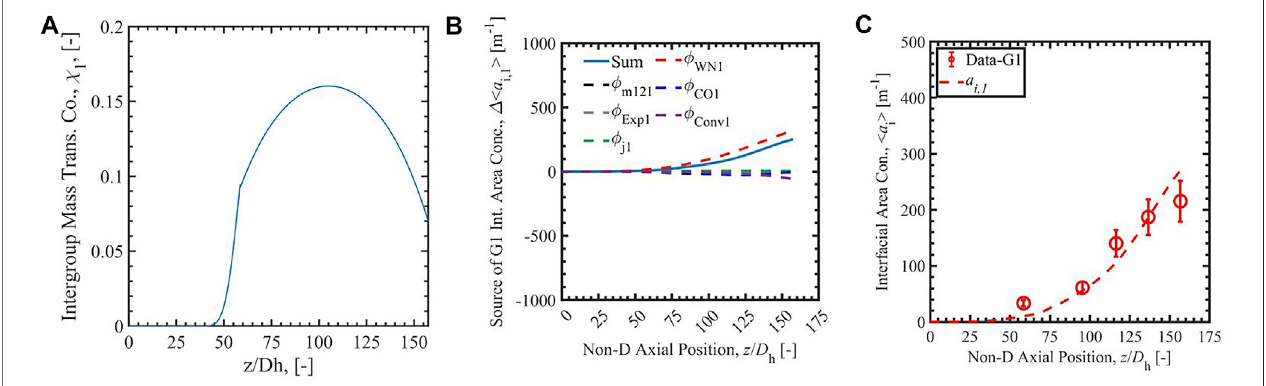
FIGURE 6 | The Run 1 results of group-1 intergroup mass transfer coef fi cient (A) , the source of group-1 interfacial area concentration (B) , and the interfacial area concentration (C) calculated with empirical correlation (Zhu et al., 2020) (fourth row).